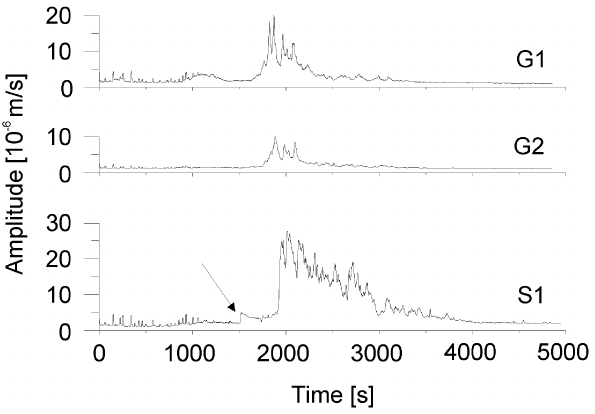
Fig. 3. Graphs of amplitude vs. time recorded by the upstream seis- mic network. The arrow indicates a small peak that has preceded the arrival of the debris-flow wave at the S1 sensor.